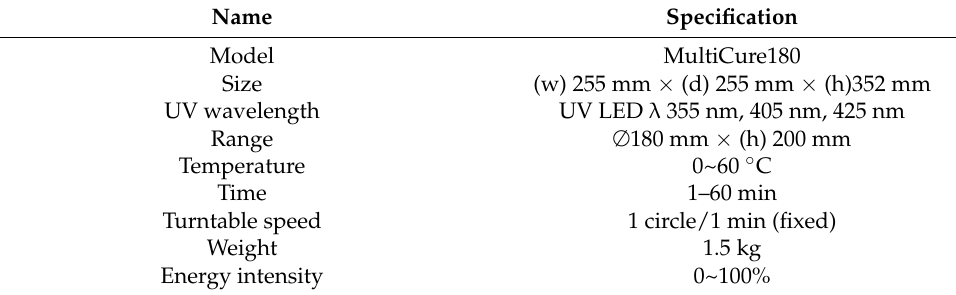
Table 7. The specifications of the MultiCure180.